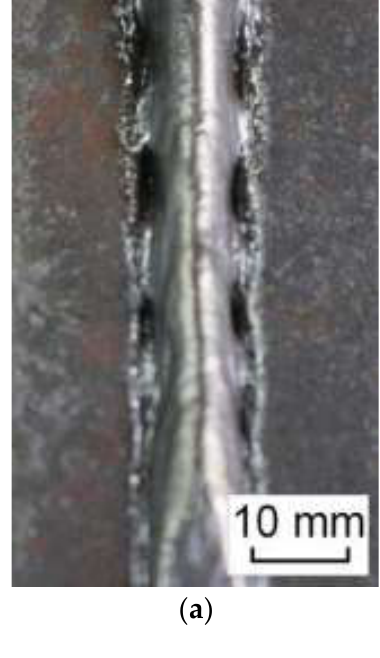
Figure 5. Undercut defects ( a ) beside a weld bead, adapted from [11], and ( b ) internal and external identified using X-ray non-destructive testing, adapted from [4].